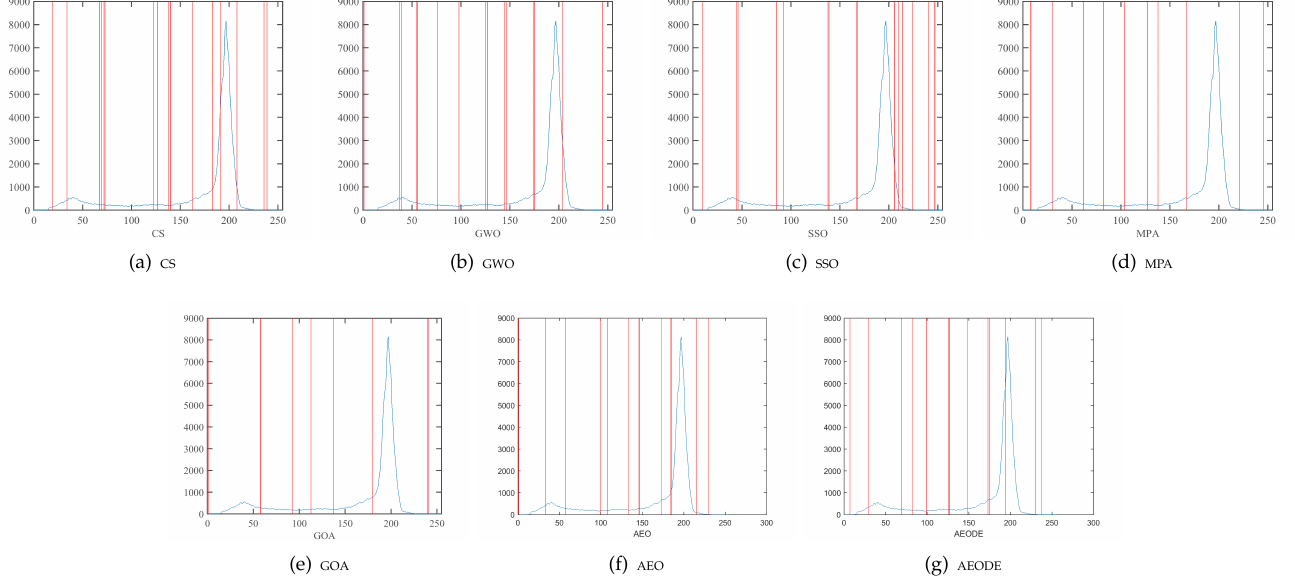
Figure 11. The threshold values at level 19 over the histogram of I10.